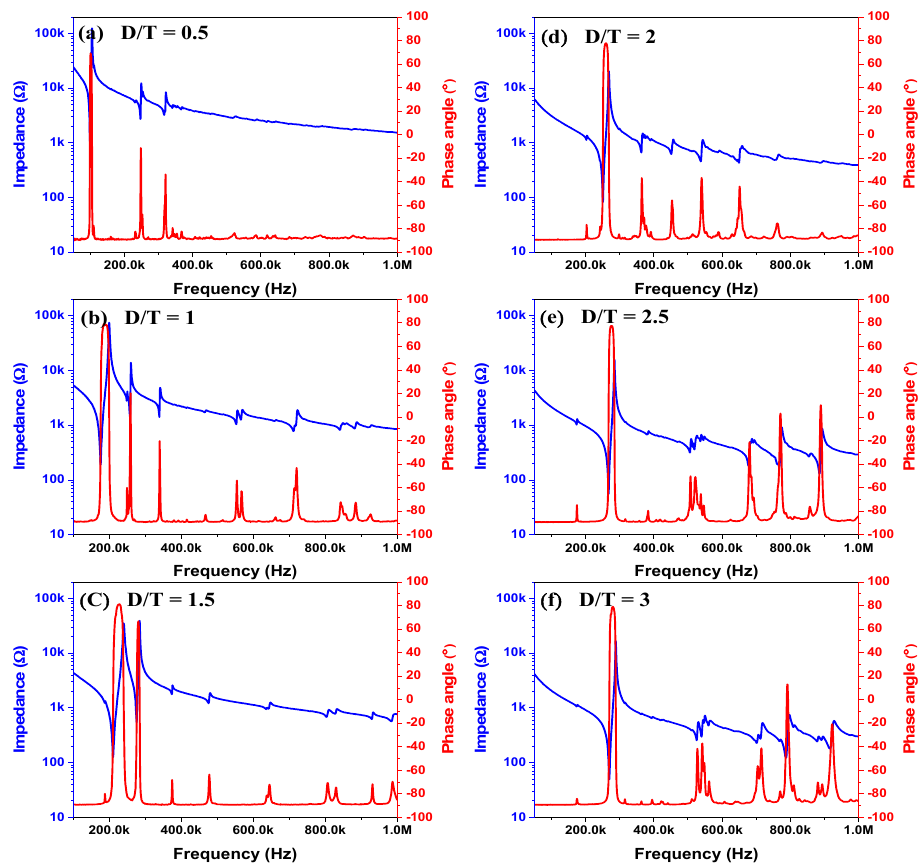
Figure 3. Impedance’s magnitude and phase angle vs. frequency of BZT–BCT ceramics with various D/T ratios (D/T): ( a ) D/T = 0.5, ( b ) D/T = 1, ( c ) D/T = 1.5, ( d ) D/T = 2, ( e ) D/T = 2.5, ( f ) D/T = 3.